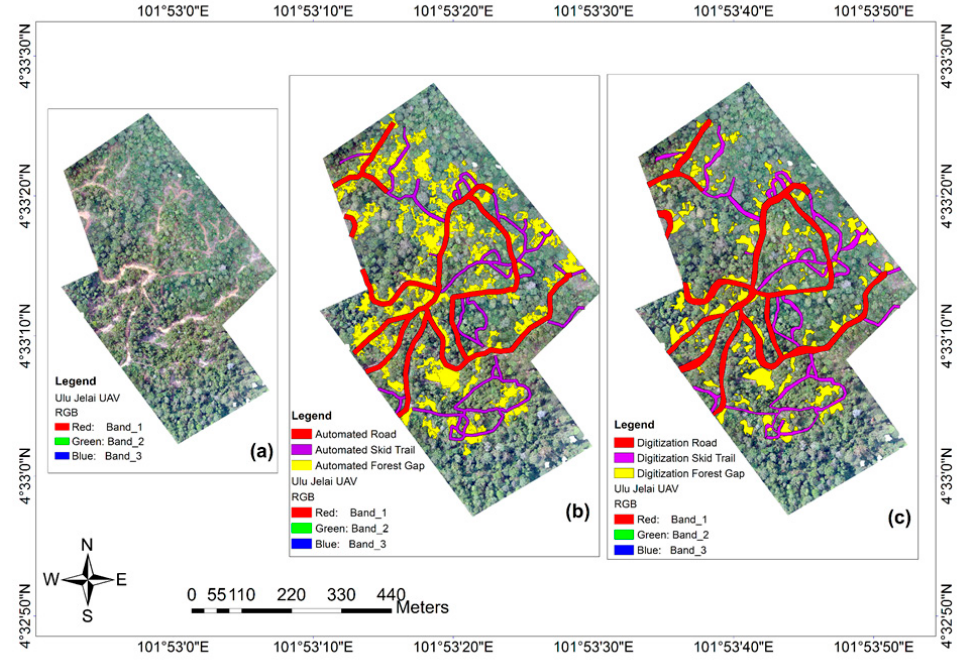
Figure 16. The extracted map of roads, skid trails and forest canopy gaps of ( a ) UAV image; ( b ) automatic detection; and ( c ) manual digitization.